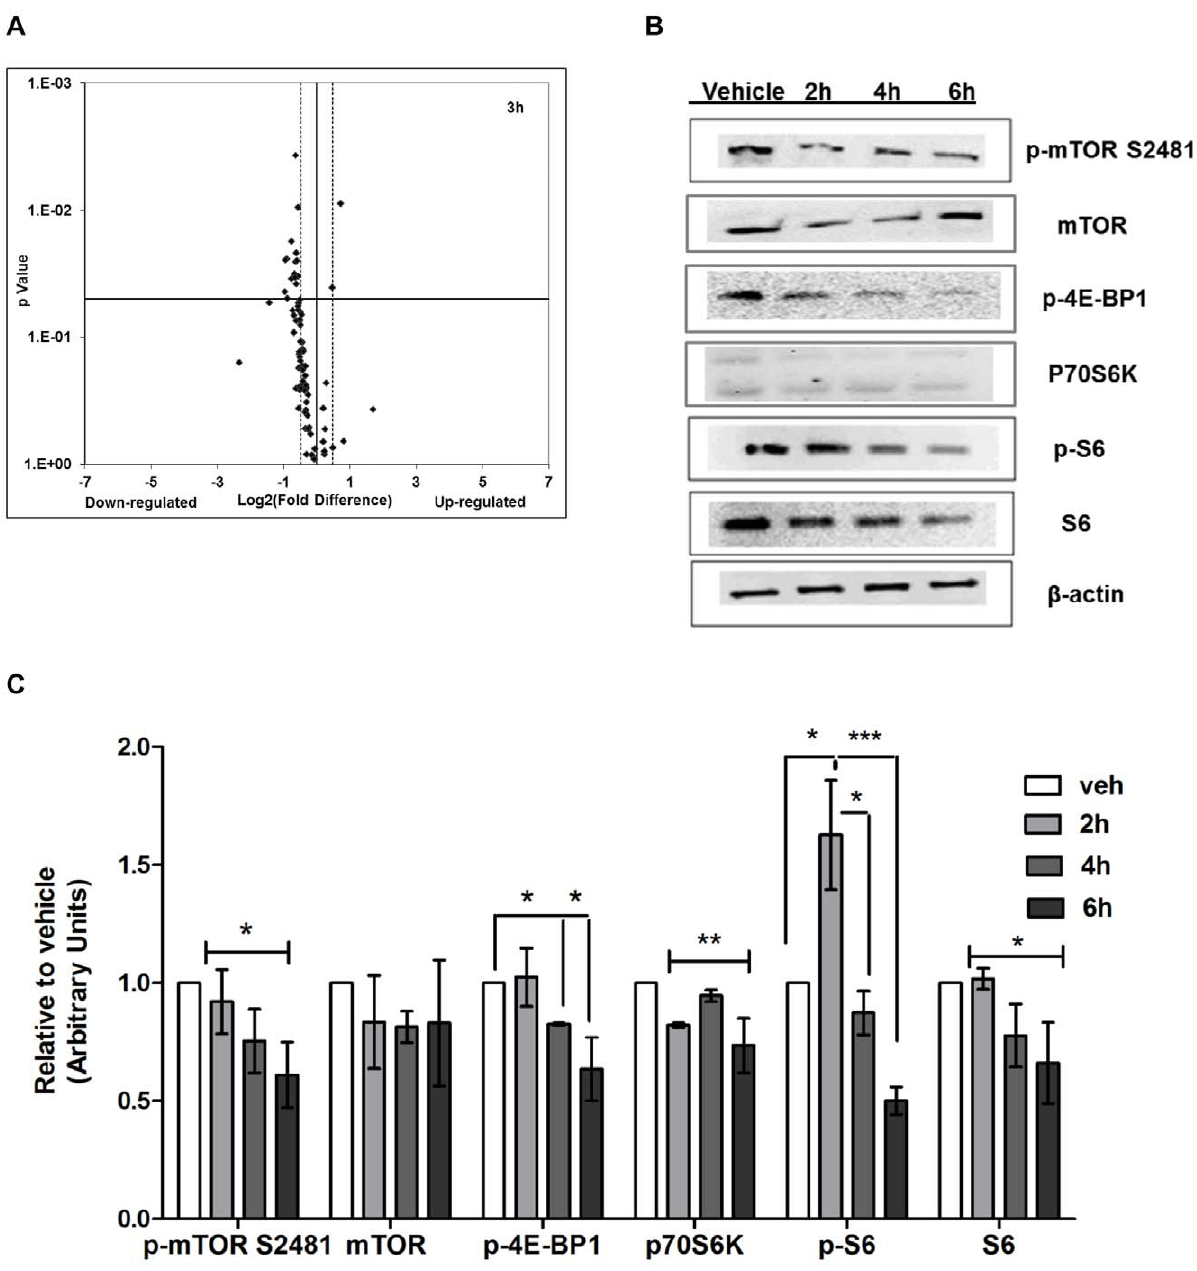
Figure 1. Reishi decreases the expression of PI3K/AKT signaling pathway genes and of mTORC1 effectors. A. Total SUM-149 cell RNA extraction was performed from three different experimental plates treated with 0 mg/mL (n=3/vehicle) or 0.5 mg/mL Reishi (n=3/treatment) for 3 hours. RT 2 PCR arrays designed to profile the expression of PI3K/AKT pathway-specific genes were used according to manufacturer’s instructions (SA Biosciences). Volcano plot shows the effects on gene expression analyzed at 2 1.4 $ 1.4 log 2 -fold change (dashed lines). Down-regulated genes are to the left of the vertical black line while up-regulated genes are to the right. Statistically significant ( P , 0.05) regulated genes are above the horizontal black line. B. SUM-149 cells were grown in 5% FBS media for 24 hours prior to treatment with vehicle (0 mg/mL) or Reishi extract (0.5 mg/mL) for 2, 4, and 6 hours before lysis. Equal amount of protein from each sample was used for Western blot analysis with antibodies against mTORC1 effector proteins. C. Columns represent means 6 SEM of integrated density units of protein, normalized to b -actin levels and shown relative to vehicle controls (without Reishi treatment). Statistically significant differences are shown at * P , 0.05, ** P , 0.01, *** P , 0.0001. doi:10.1371/journal.pone.0057431.g001 vehicle or 28 mg/kg BW of Reishi for a period of 13 week. Mice were weighed weekly and tumor volume was measured once a [20,21]. After tumor establishment (1 week post-inoculation), the week along two major axes using calipers measurements. Tumor animals were randomly divided into control (n= 11) and volume (mm 3 ) was calculated as follows: p /6 (L)(W)(H). The experimental (n= 11) groups. Mice were gavaged every day with relative tumor volumes were calculated as the ratio of the average